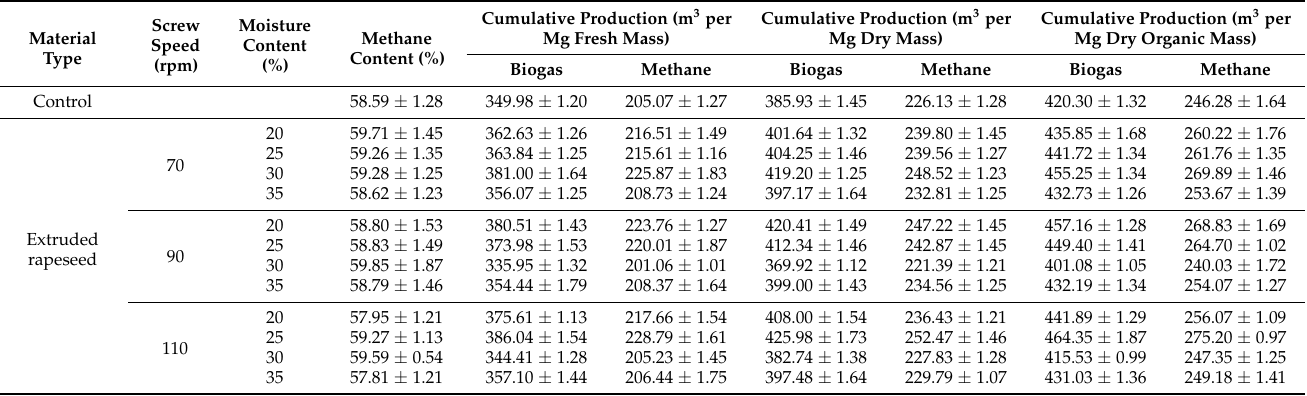
Table 6. Biogas efficiency of extruded rapeseed straw (before modification of the extruder screw; ±